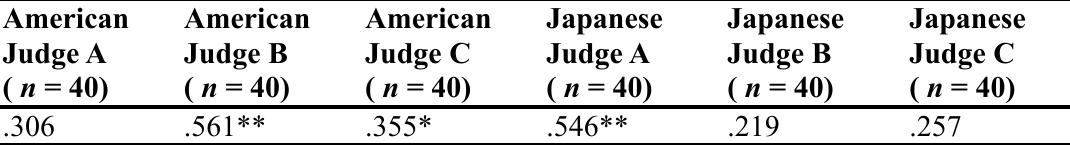
Correlations between Intelligibility and Accentedness (Pearson’s r